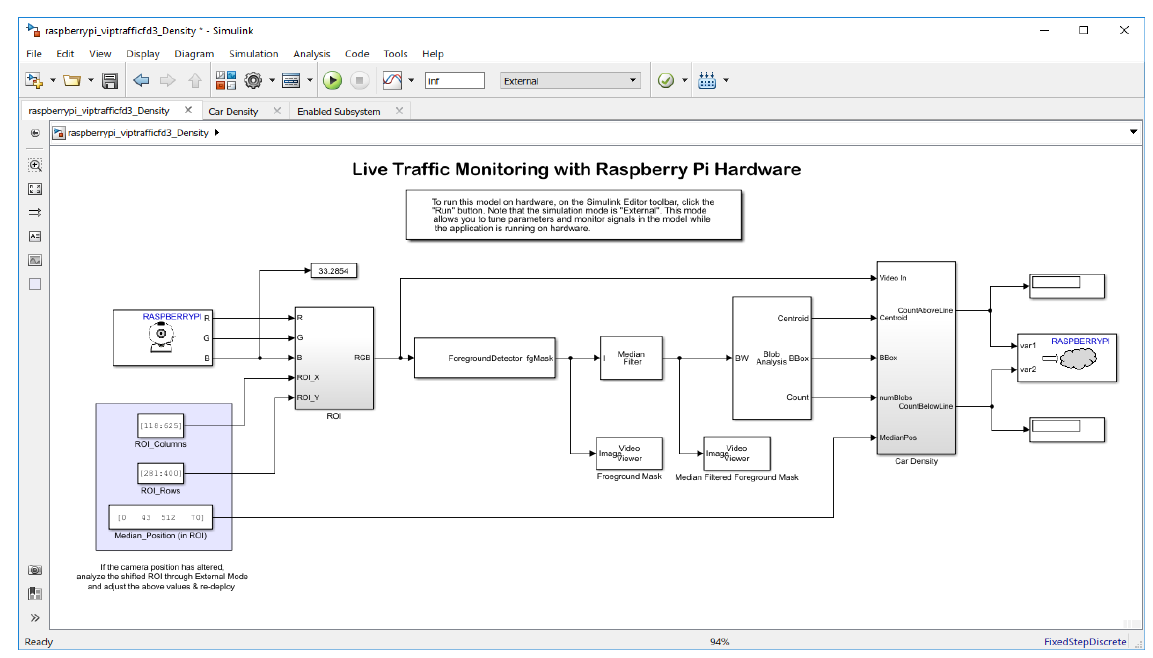
Figure 2. Simulink model for IoT sensor data